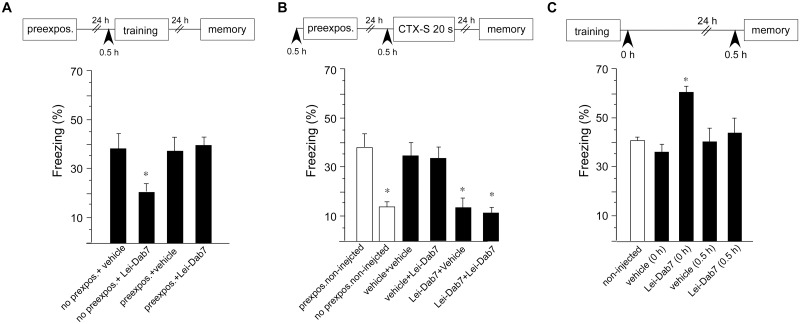
Pre-exposure of mice overcomes impaired contextual fear after inhibition of SK2 channel function.Foot-shock intensity was reduced from 0.7 mA to 0.5 mA. (A) Intrahippocampal injection of the SK2 antagonist Lei-Dab7 before training impaired freezing when compared to non-treated mice. The same treatment showed no impairment when animals were pre-exposed for 5 min to the conditioning context 24 h before the training. Vehicle-treated animals were not different from non-treated animals (n = 7/group). (B) The effects of SK2 blockade before pre-exposure to the conditioning context on subsequent contextual fear conditioning in which 20 sec placement to shock interval is employed (CTX-S 20s). Injection of Lei-Dab7 before 5 min pre-exposure to context eliminated facilitation of the acquisition of context conditioning at a 20 sec placement to shock interval. Injection of vehicle before pre-exposure or 20 sec placement to shock training phase did not influence contextual pre-exposure effect (n = 8–9/group). (C) Lei-Dab7 was injected at the indicated time points after the training and before the memory test. Statistical comparison was made versus non-injected animals (n = 7–9/group). Arrows in the schematic experimental diagram indicate time points of Lei-Dab7 injection. Freezing was measured in the memory test 24 h after training. Data presented are the mean ± SEM. Statistics was performed by two-way ANOVA with Bonferroni multiple comparisons test (*p < 0.05).